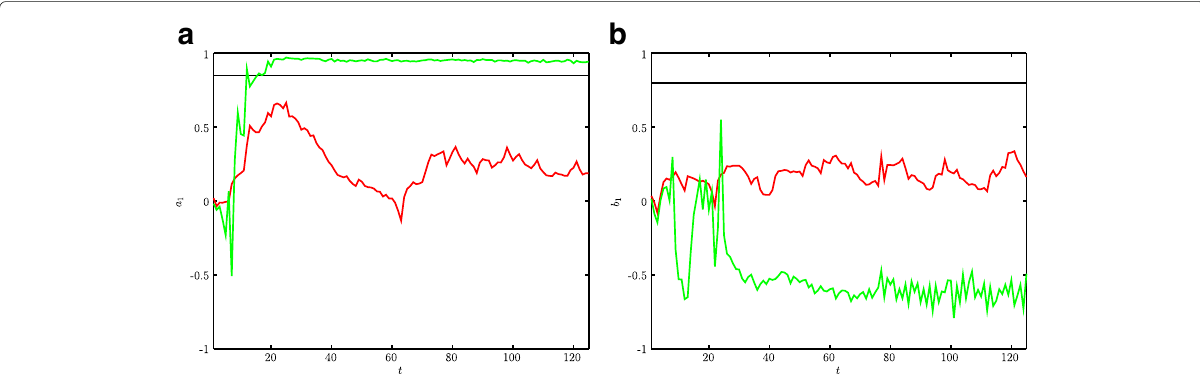
Fig. 4 True (black) and estimated (DA PF in red, IS PF in green) a 1 and b 1 for the proposed SMC methods with unknown ARMA(1,1) parameters. a a 1 tracking ( H = 0.7, unknown σ 2 u ). b b 1 tracking ( H = 0.7, unknown σ 2 u